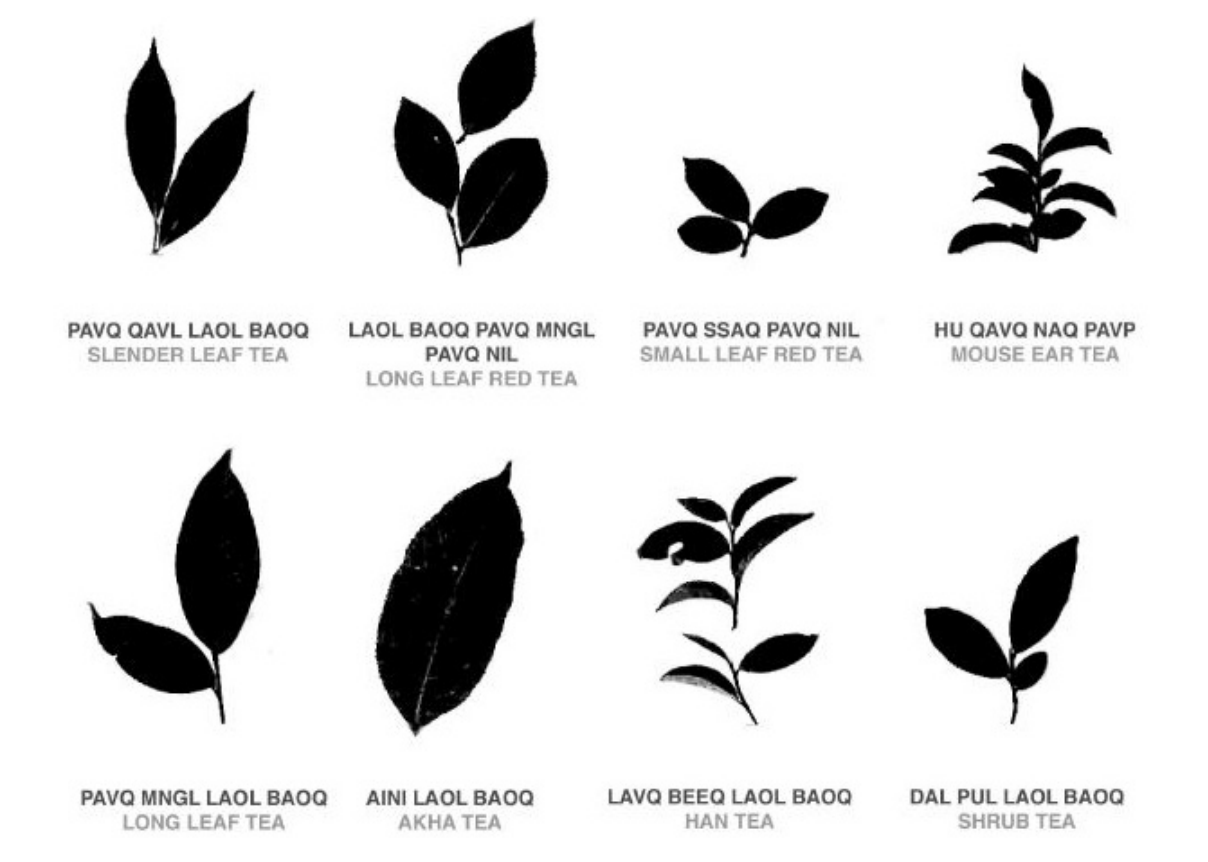
Fig. 3 . Example of local classification of tea types in